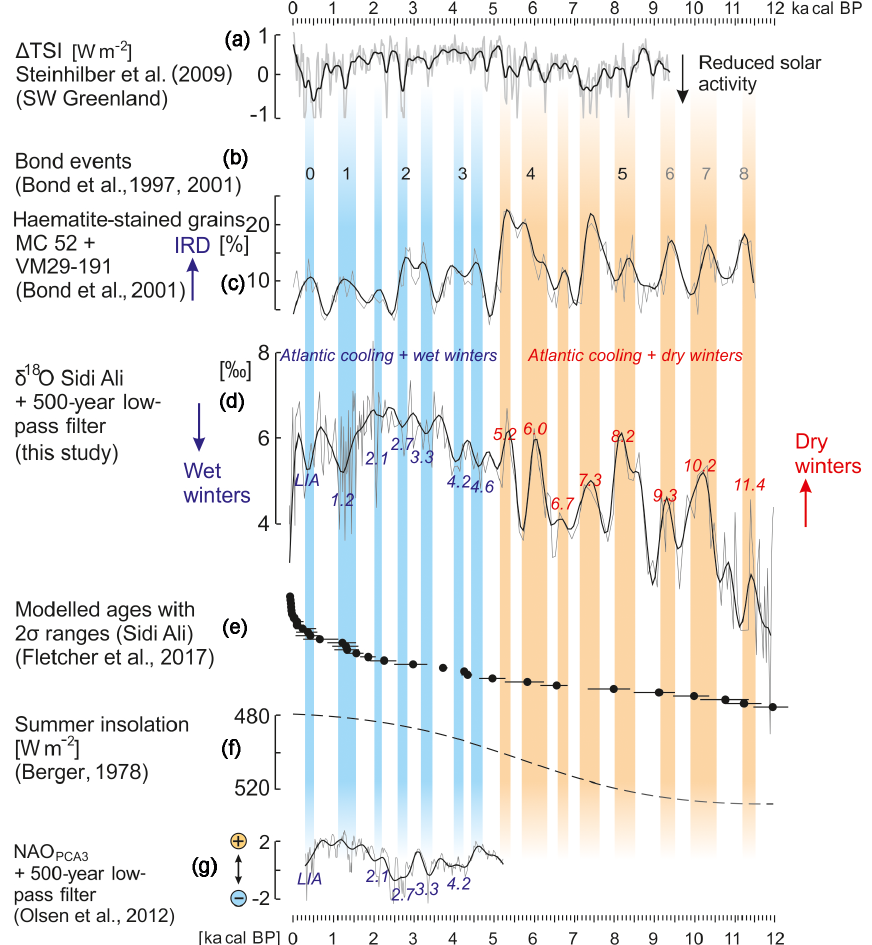
Figure 3. Holocene North Atlantic ice-rafted debris record versus Western Mediterranean (Sidi Ali) winter rain record. (a) Total solar irradiance ( (cid:49) TSI; Steinhilber et al., 2009). (b) Holocene Bond events 0 to 8 derived from Bond et al. (1997, 2001). (c) Ice-rafted debris (IRD) record based on haematite-stained grains of stacked MC52 and VM29-191 cores from the subpolar North Atlantic (Bond et al., 2001); the black line shows results of a low-pass filter (500 years) removing centennial variability. (d) Improved Sidi Ali δ 18 O record from closely related species Fabaeformiscandona sp. and Candona sp. (Zielhofer et al., 2017a, and this study). The grey line represents the original data. The black line shows results of a low-pass filter (500 years). Blue/red numbers and pale blue/orange bars indicate North Atlantic cooling events and wet/dry winters in the Western Mediterranean. (e) Modelled ages with 2 σ ranges (Fletcher et al., 2017). (f) Summer insolation (65 ◦ N, June; Berger, 1978) (note reversed axis). (g) Palaeo-NAO record (Olsen et al., 2012) with a 500-year low-pass filter.